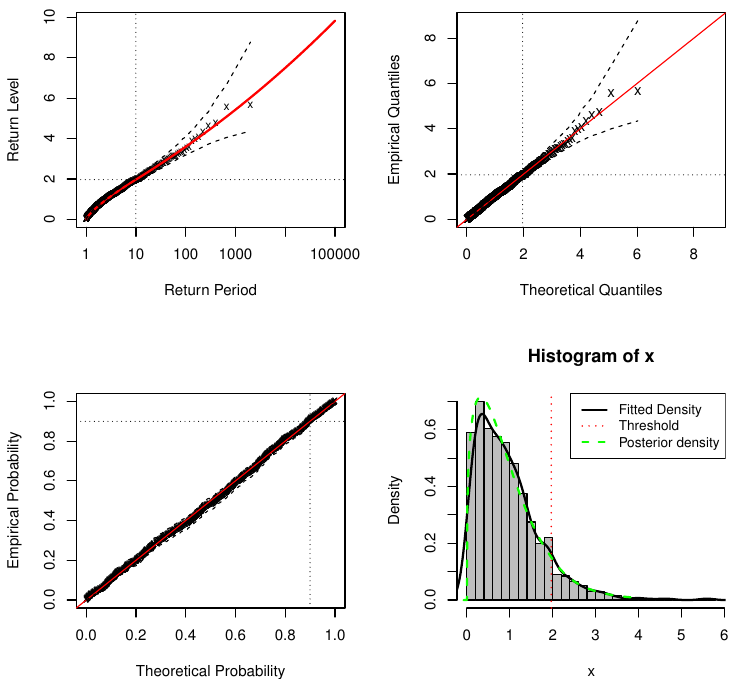
Figure 4. Standard model fit diagnostics for the DPMW-PPR model fitted to the simulated data with n = 1000. (The top left corner is the return level plot, the top right corner is the quantile plot, the bottom left corner is the probability plot, and the bottom right corner is the density